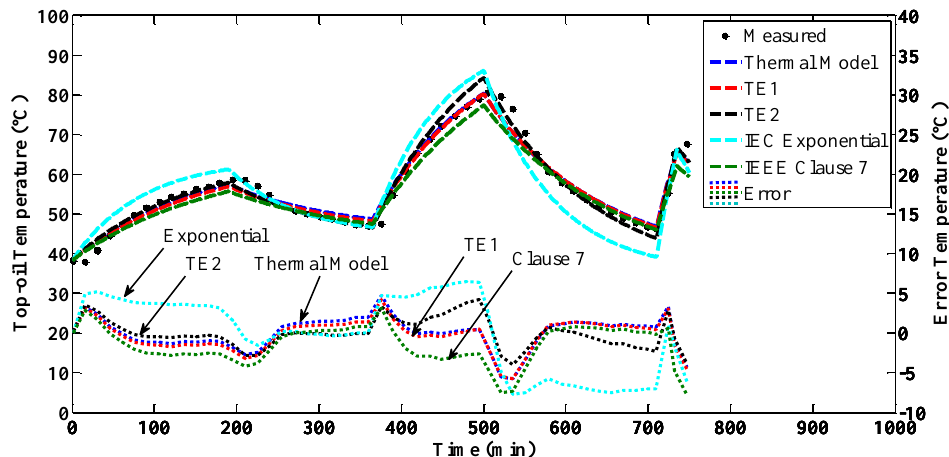
Figure 14. TOT based on different thermal models for TX8.